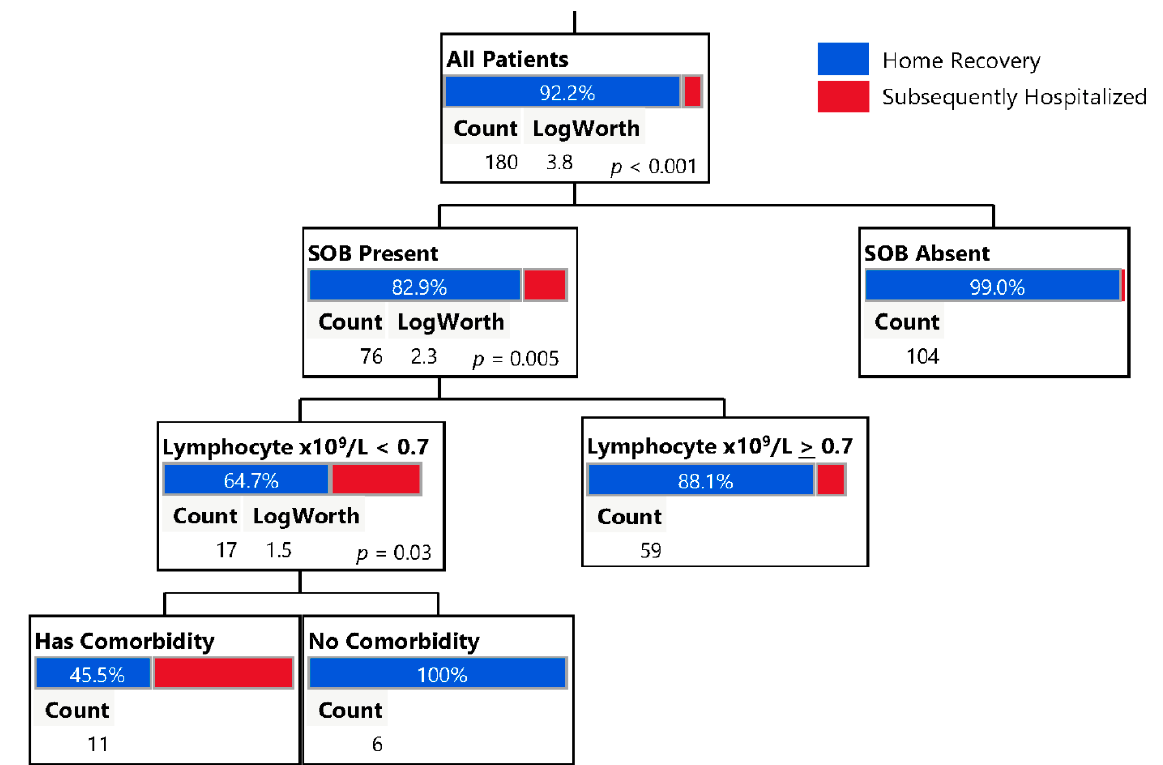
Figure 5. Outcome decision tree analyses. Partitioning of data, where patient outcome is a binary outcome (Home Recovery or Subsequently Hospitalized). Variables included in this analysis were all symptoms, presence of any known comorbidities, lymphocytes, cycle threshold, age, BMI, and sex. Partitioning identifies SOB ( p < 0.001), lymphocyte counts ( p = 0.005), and comorbidities ( p = 0.03) to be most associated with need for hospitalization. Observations with missing data are randomly and iteratively assigned to one of two sides of the split to utilize the entire cohort.